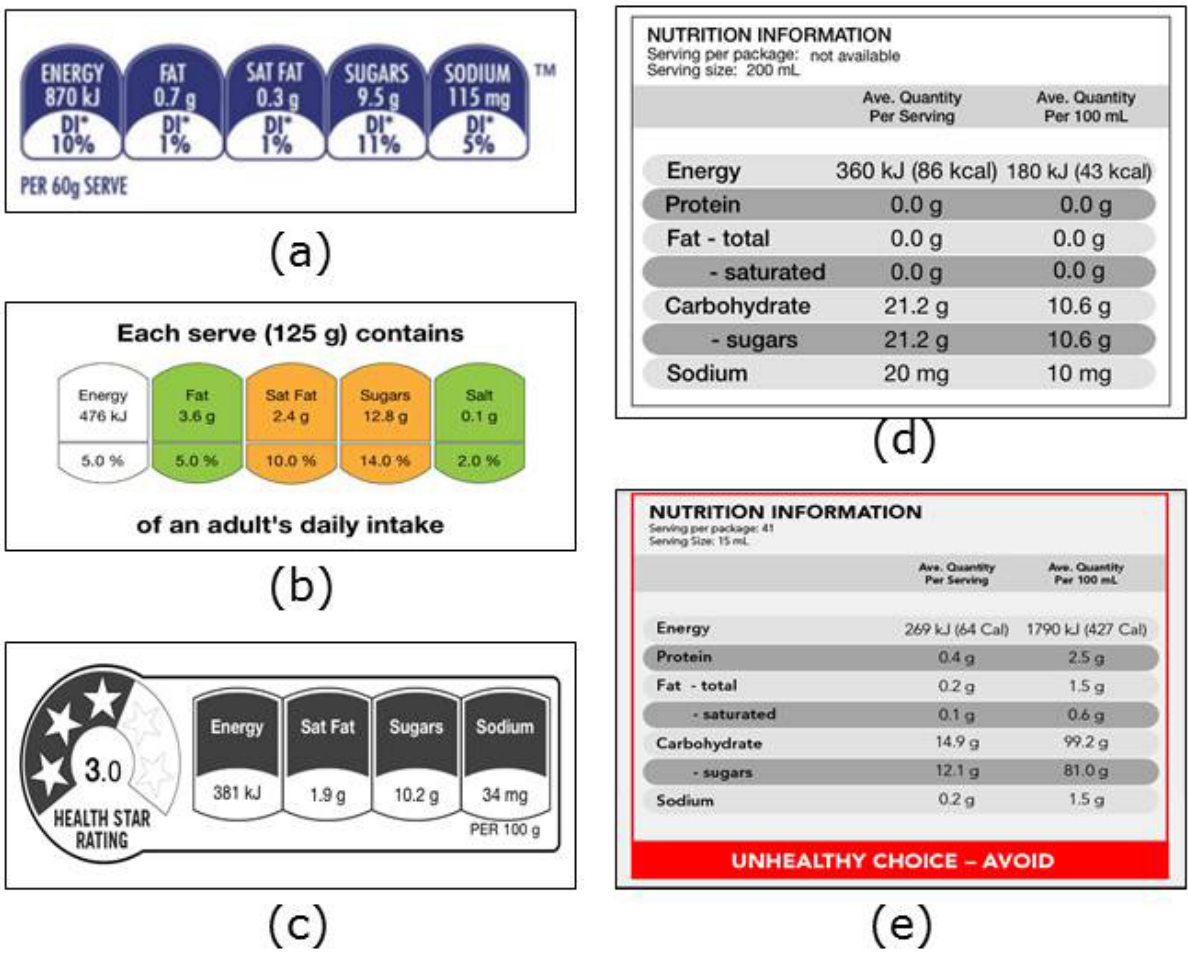
Figure 1. Nutrition-labeling formats allocated to intervention and control groups in the trials. (a) Daily Intake Guide*. (b) Traffic Lights. (c)